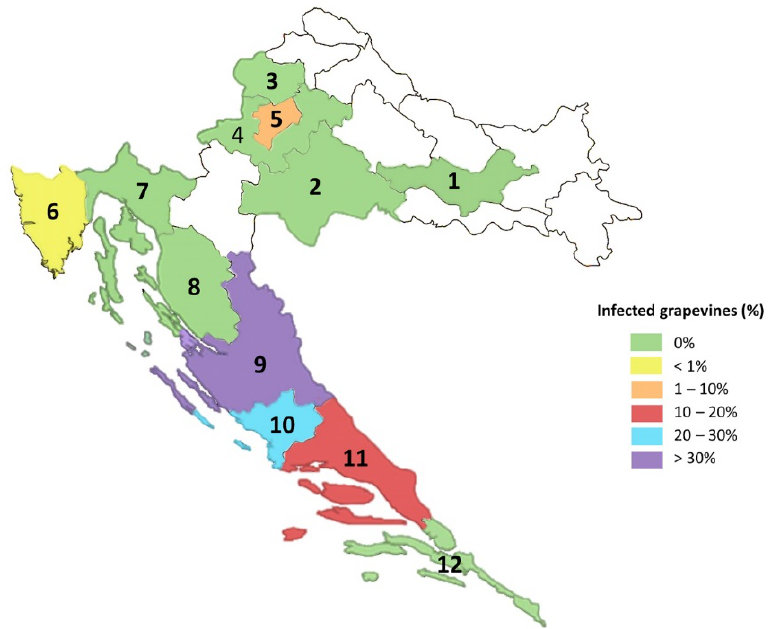
Figure 3. Distribution of GBV-1 throughout the Croatian counties by percentage of infection; 1—Požega-Slavonia; 2—Sisak-Moslavina; 3—Krapina-Zagorje, 4—Zagreb County; 5—city of Zagreb; 6—Istria; 7—Primorje-Gorski Kotar; 8—Lika-Senj; 9—Zadar; 10—Šibenik-Knin; 11—Split-Dalmatia; 12—Dubrovnik-Neretva. Other counties, shown in white, were not included in the Table 2. Number of GBV-1-positive grapevines identified by real-time PCR. For each positive loca- tion details concerning the location and type of vineyards (commercial or collection) are given. Only locations where presence of GBV-1 was confirmed are shown.